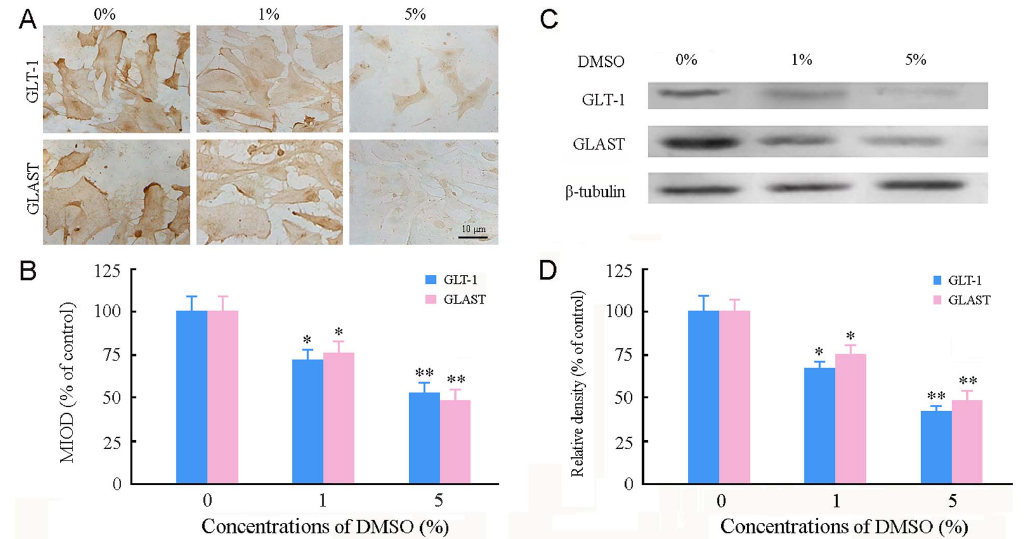
Figure 7. Effects of DMSO on expression of GLT-1 and GLAST in cultured mouse cortical astrocytes. ( A ) Representative micrographs showing immunoreactivity of GLT-1 and GLAST in astrocytes treated with various concentrations of DMSO for 24 h. ( B ) Mean integrated optical density (MIOD) of immunostaining for GLT-1 and GLAST. ( C ) Representative western blot bands showing expression levels of GLT-1 and GLAST in astrocytes. ( D ) Quantitative analysis revealed that GLT-1 and GLAST protein levels were decreased in astrocytes treated with DMSO in a dose- dependent manner. Data are shown as a mean 6 SEM of five (for immunostaining) or four (for Western blot) independent experiments performed in triplicate. * P , 0.05 and ** P , 0.01 versus control